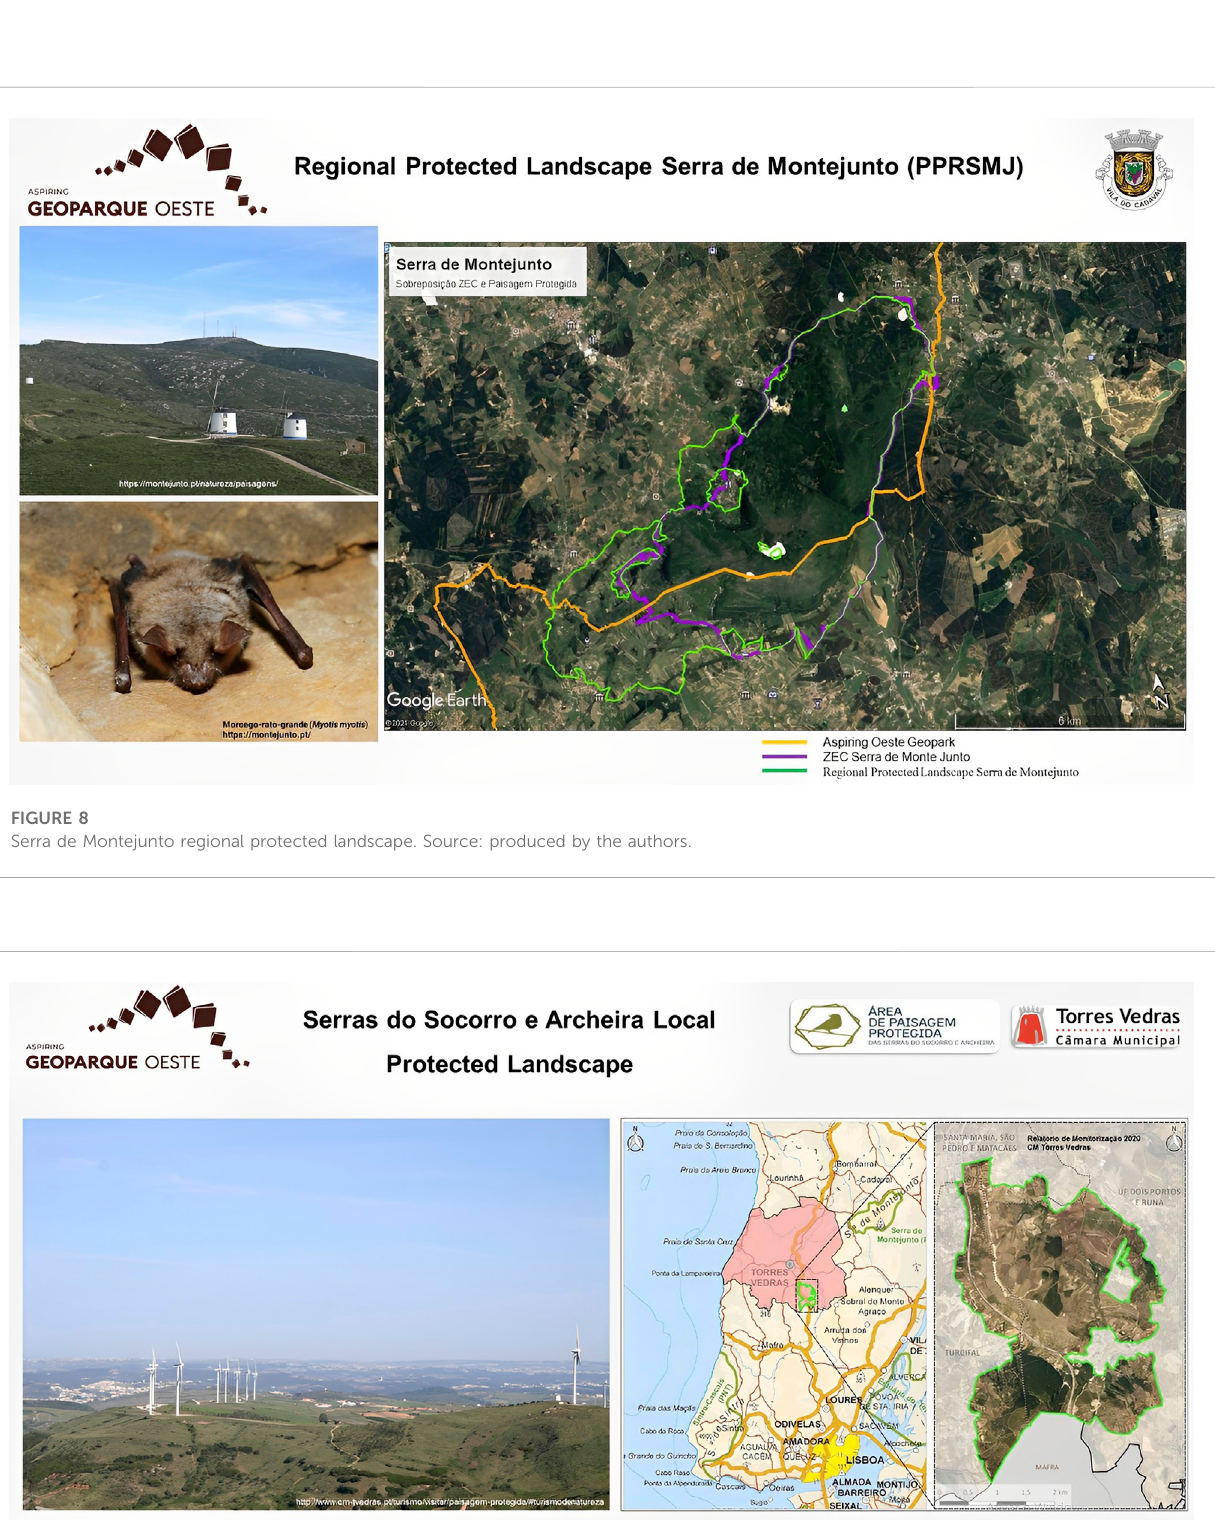
Frontiers in Environmental